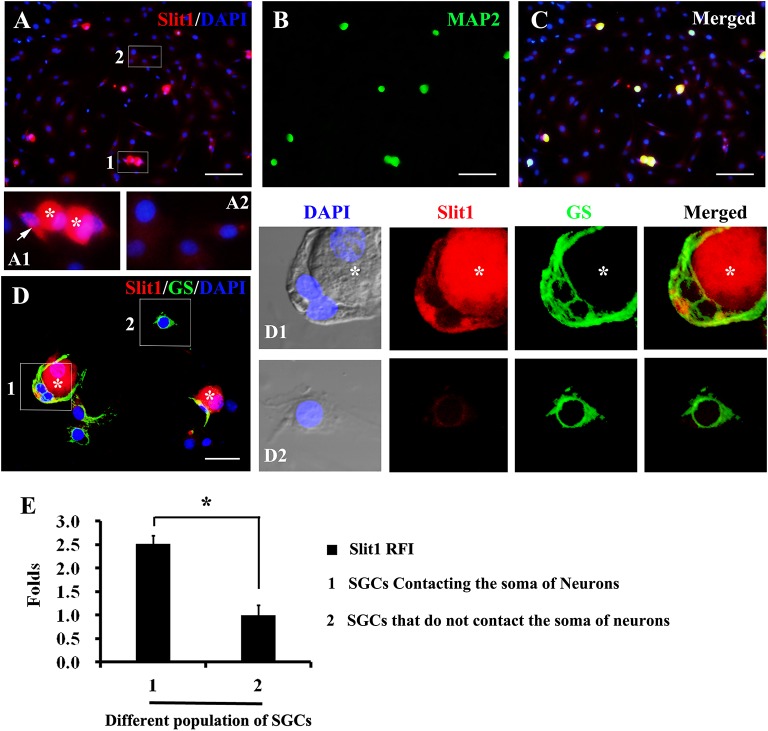
Expression of Slit1 in SGCs directly in contact with the neuronal soma in vitro
(A–C) Primary cultured DRG cells were double labeled with Slit1 and MAP2 immunochemistry, nuclear staining by DAPI. (A) Slit1 (red) and DAPI (blue) merged image. The box 1 shows SGCs in contact with neuron bodies, Panel (A1) is its enlarged image, with arrows indicating SGCs in contact with neuronal soma (white asterisks); and the box 2 shows SGCs located far from neuron bodies as showed in its enlarged image (A2). (B) MAP2 (green) image. (C) Slit1 (red), MAP2 (green) and DAPI (blue) merged image. (D) Slit1 and GS double immunostaining were performed on cultured DRG cells, nuclear staining by DAPI. The box 1 shows SGCs in contact with Slit1-positive neuronal soma (white asterisks). The box 2 shows SGCs located far from neuron bodies. Panels (D1,D2) lines of pictures were local enlarged images of the box 1 and box 2 showed in panel (D), respectively. The white asterisk indicates the neuronal soma. Slit1 (red), MAP2 (green) and DAPI (blue) were showed in panels (D,D1,D2). (E) Summary histograms depict the changes in Slit1 expression in two different populations of SGCs, ∗ shows the expression of Slit1 in SGCs of population 1 compared with that in SGCs of population 2 analyzed with paired t-tests, ∗
P < 0.001; bars represent the standard error of the mean; RFI, relative fluorescence intensity. Scale bar = 50 μm was showed in panels (A–C); Scale bar = 15 μm was showed in panel (D).